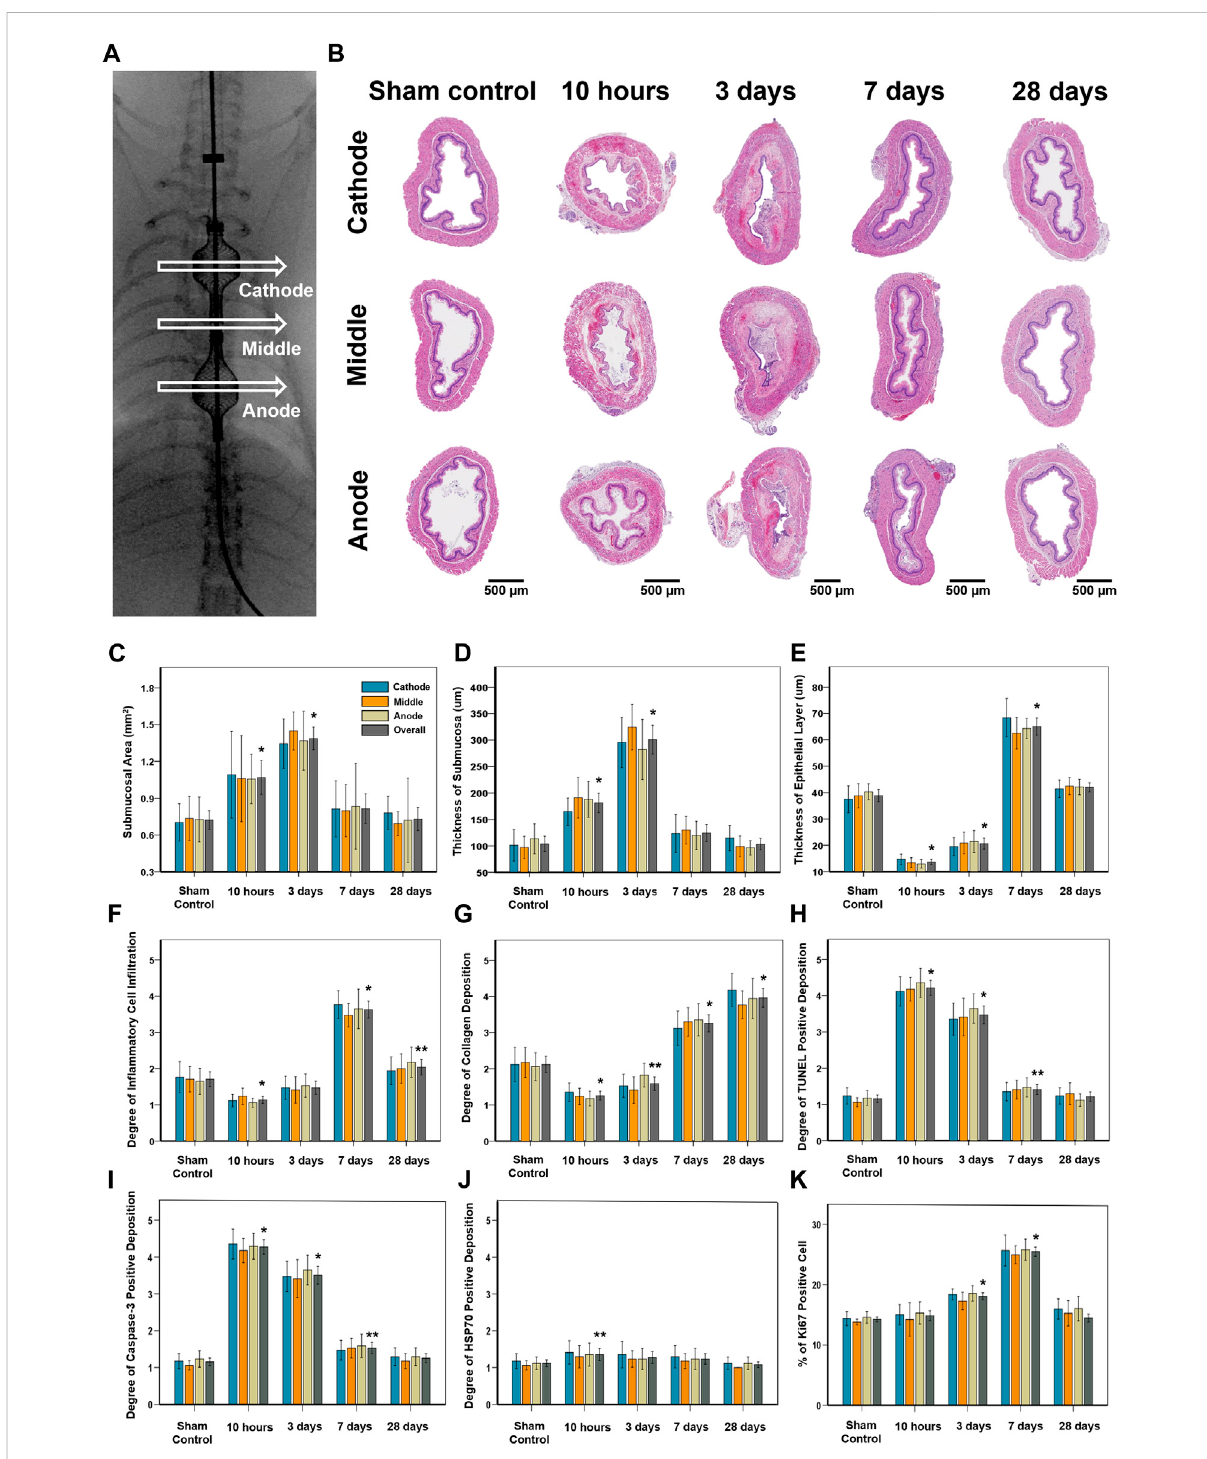
FIGURE 4 Histopathological fi ndingsinstudygroupsafterstent-directedIREintheratesophagus. (A) Radiographicimageshowsthelocationofthetissue sampled for histologic examination where the self-expandable electrode (SE) was present in the cathode SE, middle portion between the two SEs, and anode SE. (B) Representative hematoxylin and eosin-stained images show the axially sectioned esophagus after stent-directed IRE ablation showingserialhistologicalchanges.Histopathologicresultsoftheshamcontrolat10 h,3 days,7 days,and28 daysafterIREtreatmentin (C) the submucosal area, (D) thickness of submucosa, (E) thickness of the epithelial layer, (F) degree of in fl ammatory cell in fi ltration, (G) degree of collagen deposition, degrees of (H) TUNEL, (I) caspase-3, and (J) HSP70-positive deposition, and (K) percentage of Ki67-positive cell. Note: Data are presented as the mean ± SD. * p < 0.001 and ** p <